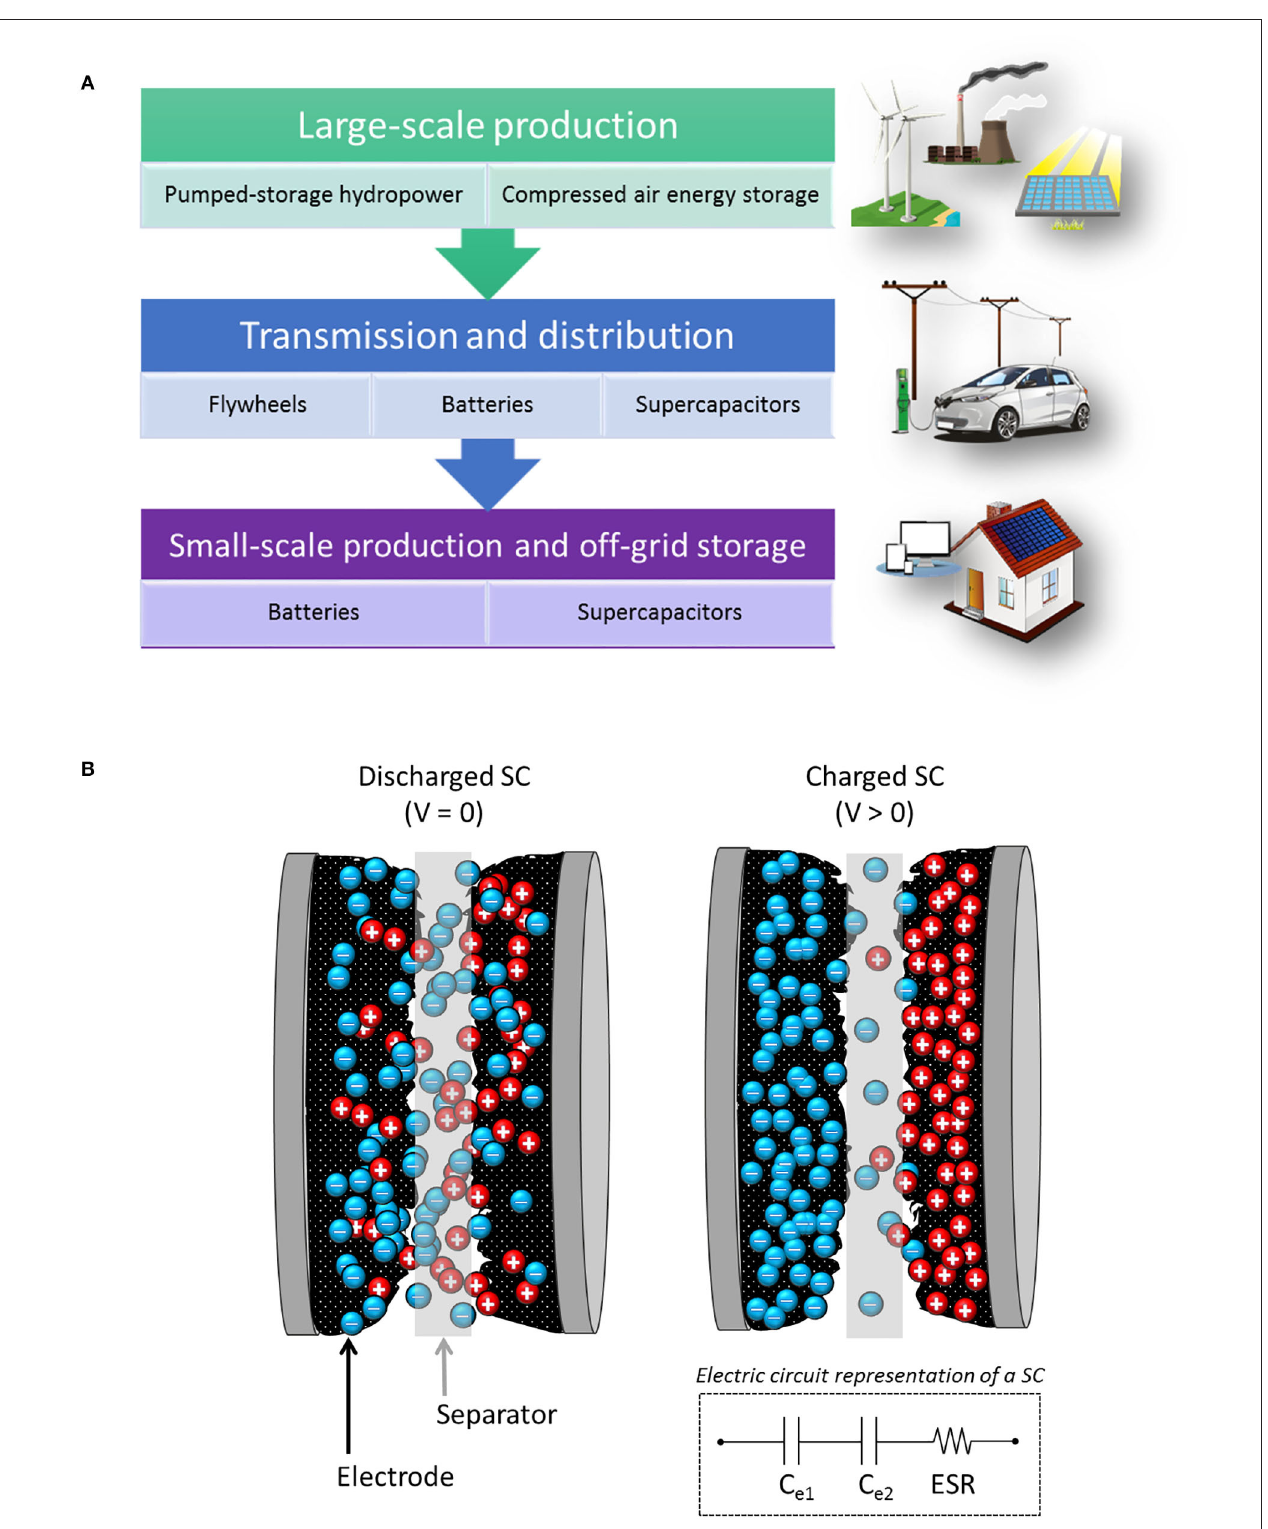
FIGURE 1 | (A) Energy storage technologies used at different scales in the power system (IEA, 2014; Aneke and Wang, 2016). (B) Mechanism of formation of the electrostatic double-layer (EDL) in a SC. In the associated electric circuit, capacitors C e1 and C e2 represent the contribution to the total capacitance of the EDL formed at the surface of each electrode. The equivalent series resistance (ESR) is also shown.